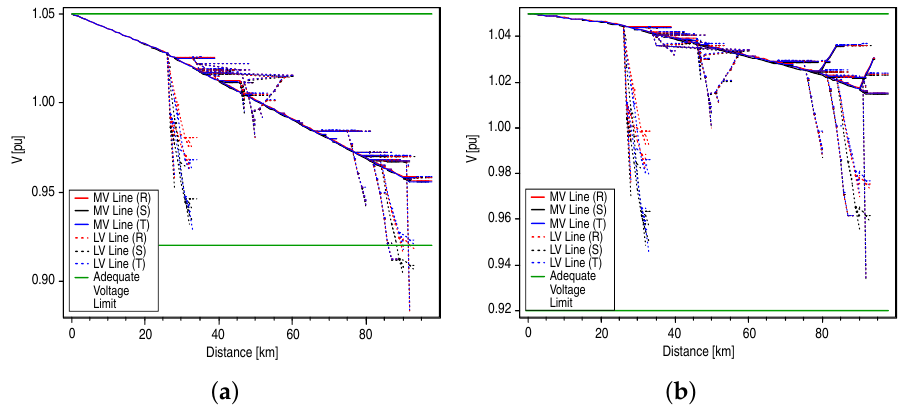
Figure 14. Scenario 2: ( a ) voltage profile before DGPV allocation and ( b ) voltage profile after DGPV